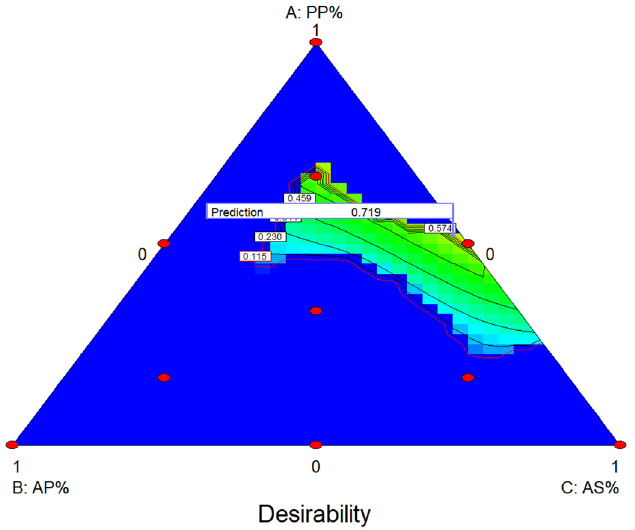
Figure 1. Contour plot of the effect of the samples on MIC based on optimization from mixture design. According to the turbidity assay results, sample No6 was shown to be the most effective at leading to a reduction of the absorbance at 620 nm as an effect of the addition of each sample at concentrations of 10 mg/mL, compared to the control (0 mg/mL) without antimicrobial extracts (Figure